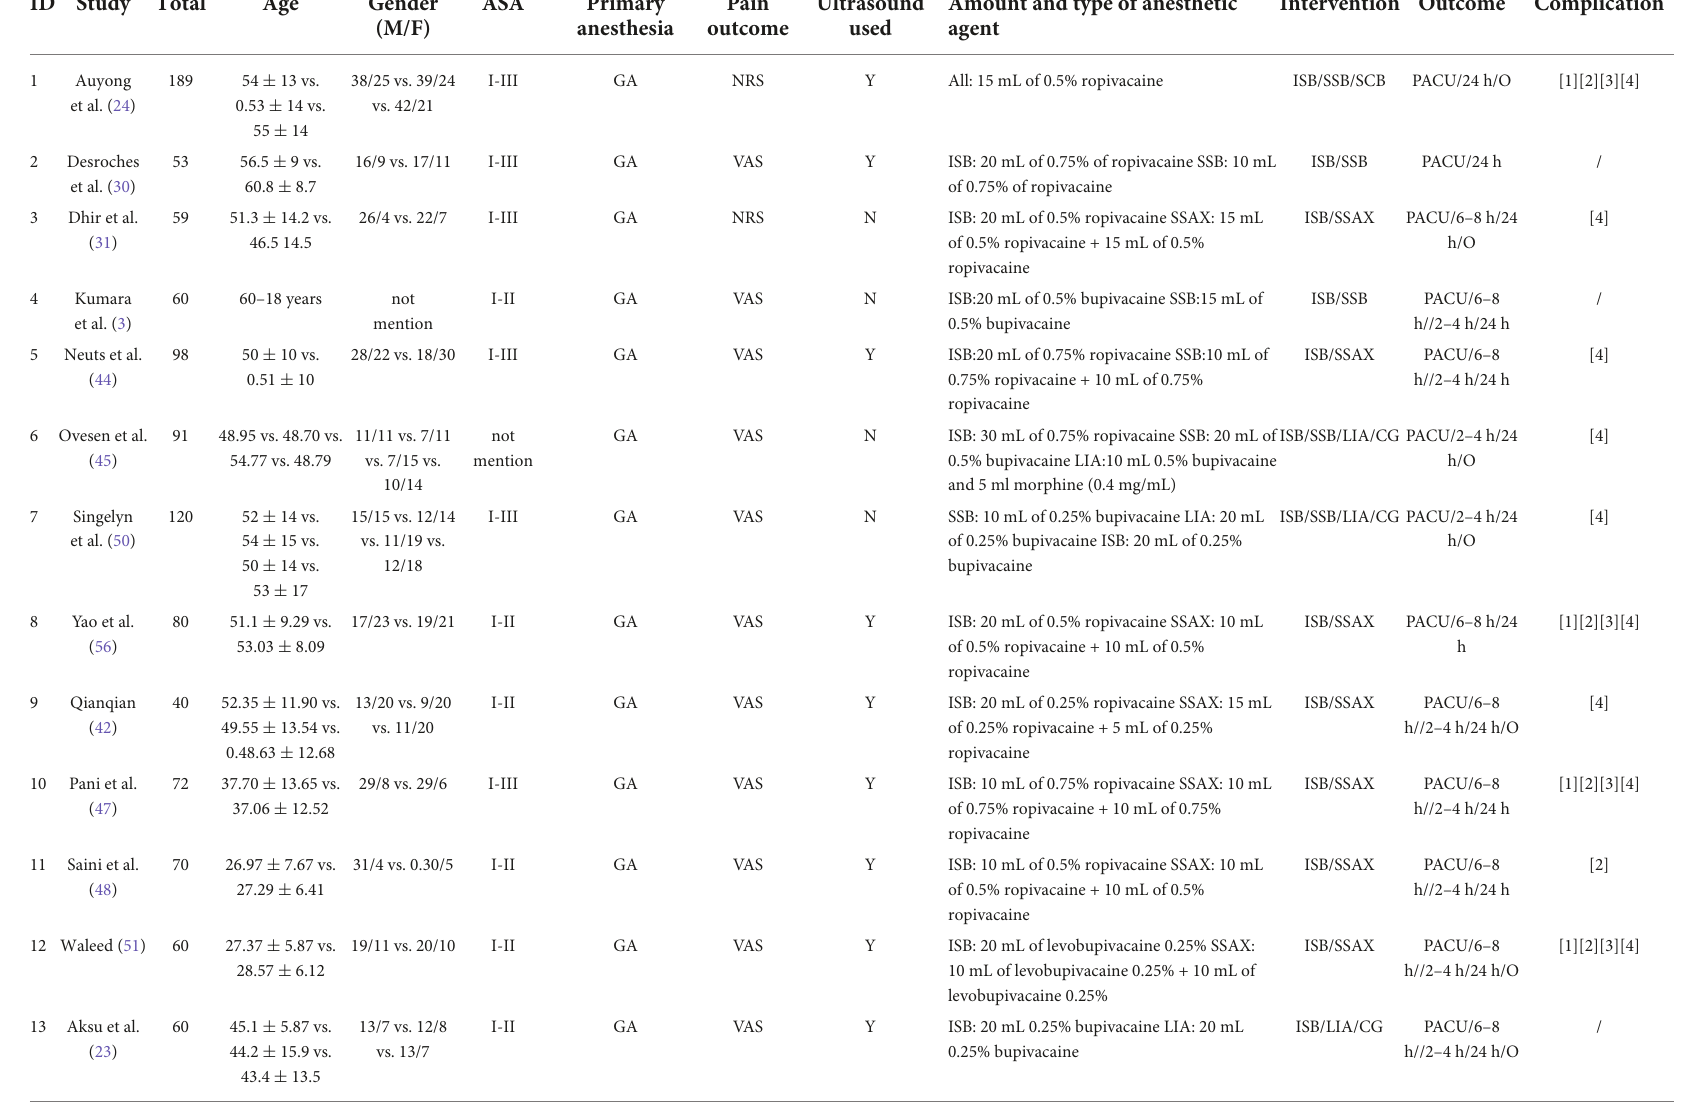
TABLE 1 Characteristics of included